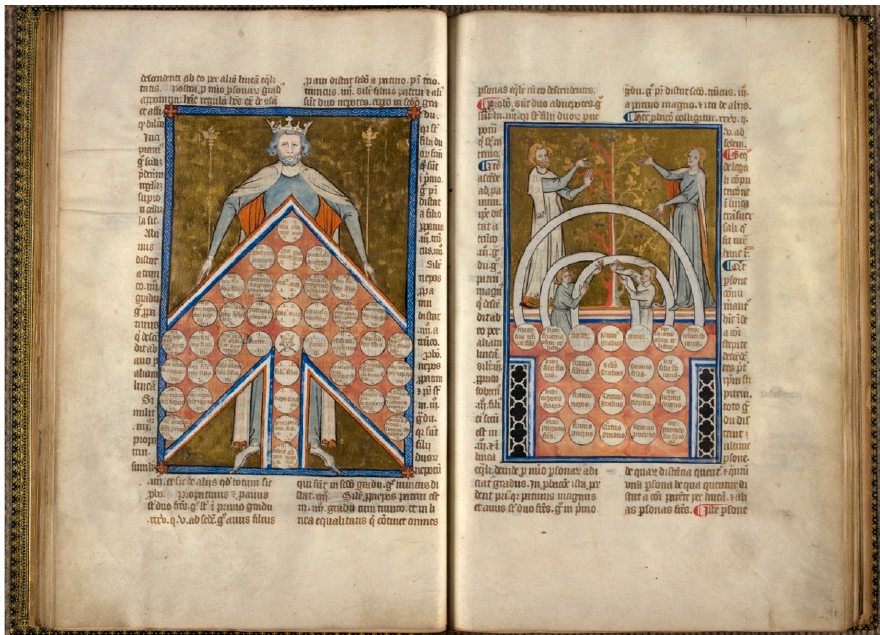
Figure 1. Johannes Andreae, Super arboribus consanguinitatis et affinitatis bound within a volume of the customary laws of Normandy, Grand Coutumier de Normandie . Consanguinity is on the left, 30 v , affinity is on the right, 31 r . Attribution: Petit Palais, Musée des Beaux-Arts de la ville de Paris. LDUT 0095. f. 030 v —031. CC BY-NC 3.0.